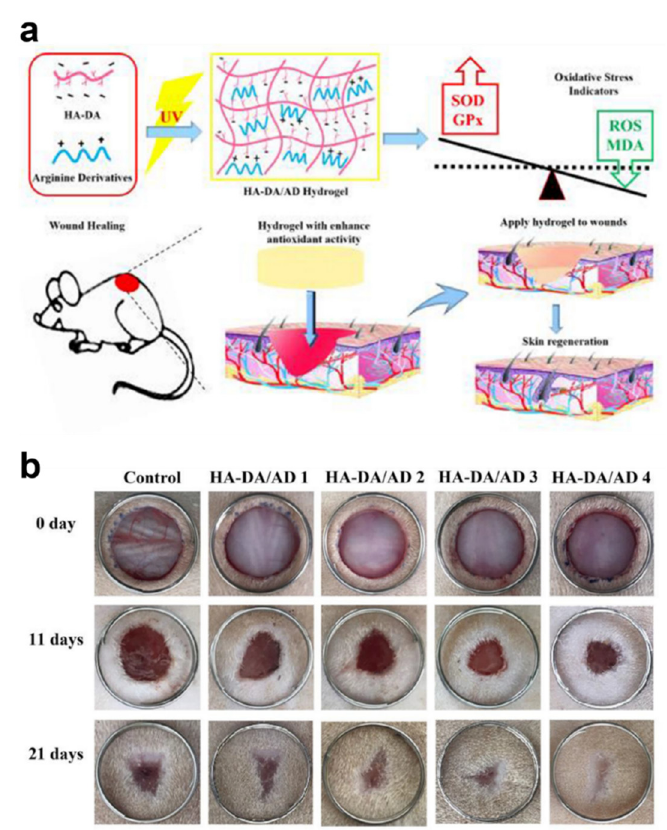
Figure 5. ( a ) Schematic illustration of methacrylated HA–catechol (HA–DA) and arginine derivatives (AD) composite hydrogels for wound healing. ( b ) Photographic images of rat skin wounds after treatments of HA–DA/AD hydrogels with various pore sizes (14.18 ± 1.54 µm for HA–DA/AD1, 13.09 ± 0.79 µm for HA–DA/AD2, 11.08 ± 1.16 µm for HA–DA/AD3, and 9.07 ± 2.17 µm for HA–DA/AD hydrogels). Treatment with PBS was used as a control. Reproduced with permission from [62]. Copyright © 2019